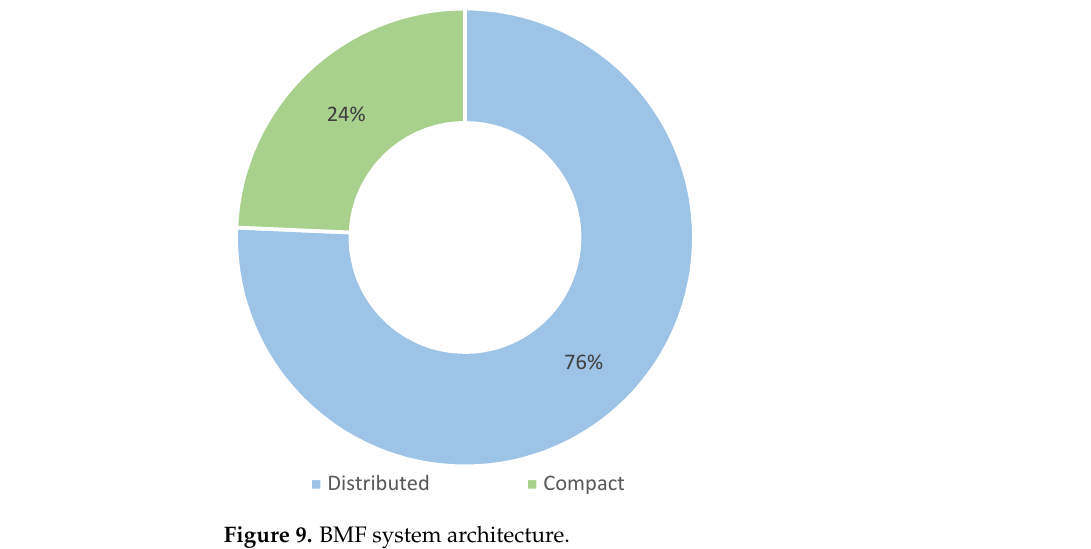
Figure 9. BMF system architecture. Table 6. BMF system or application processing device type.